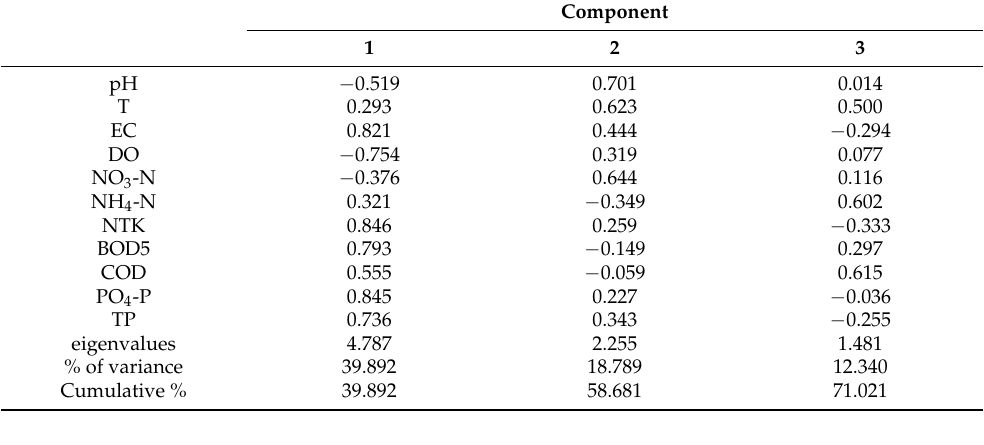
Table 6. Eigenvalues on the correlation matrices of the concentration of the physicochemical parameters, in %.